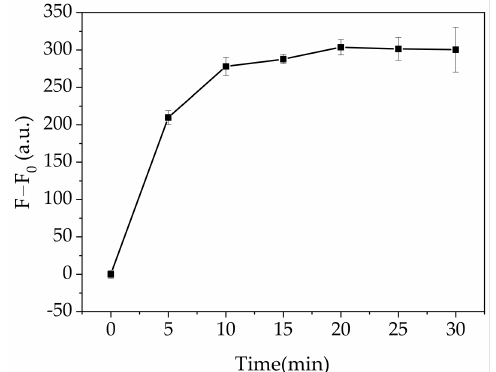
Figure 6. Effect of the incubation time on Pb 2+